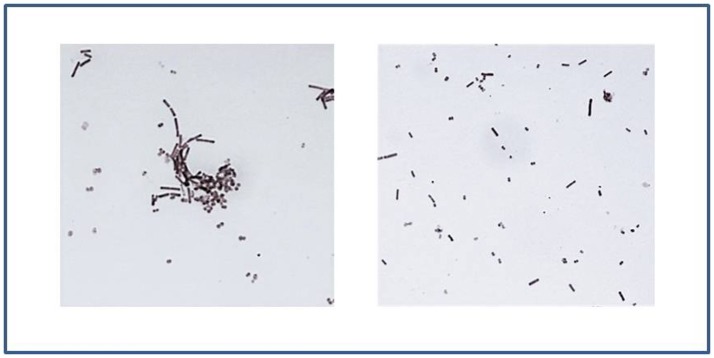
Lactobacilli interaction with piliated GC. On the left: L. crispatus BC1 shows high levels of interaction with GC after 7 min contact time, as underlined by the formation of lactobacilli-gonococci cells aggregates. On the right: after an interaction of 7 min, the ability of L. crispatus BC6 to aggregate with gonococci was excluded. Gram-stained images at 1,000 × magnification.